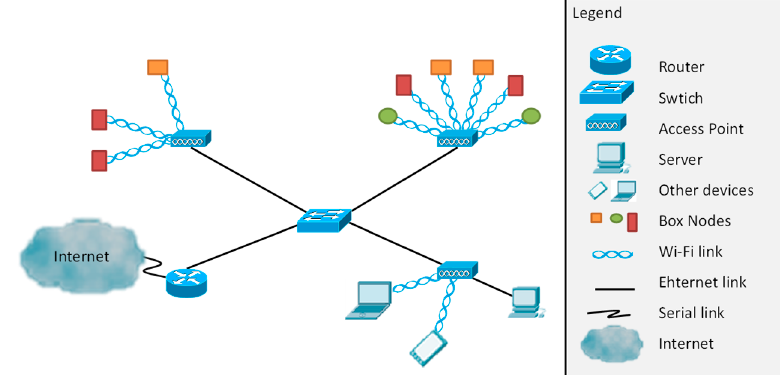
Figure 1. Network topology proposed.